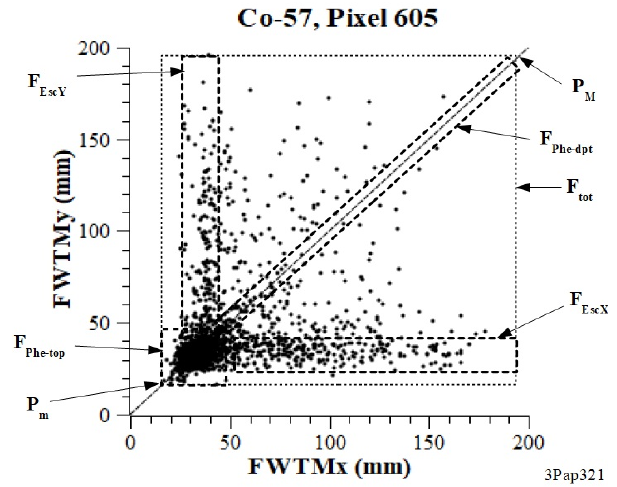
Figure 5. Domains of interest, defined in the first quadrant of the plane ( FWTMx , FWTMy ), where the spreads of 2-D charge distributions of the Co-57 data, for the crystal-pixel 605, were defined. F tot contains all the events by construction, F Phe-top contours the photo-electric interactions occurring at the top of the pixel (first mean-free-path). The domain F Phe-dpt marks out the photoelectric events taking place at greater depth in the pixel. The last two domains F EscX and F EscY regard the photoelectric events with a Lu K X-ray escaping to the X - or Y -neighboring pixel, respectively. Finally, the points of F tot not belonging to other domains, represent the domain of scattered events F scatt .